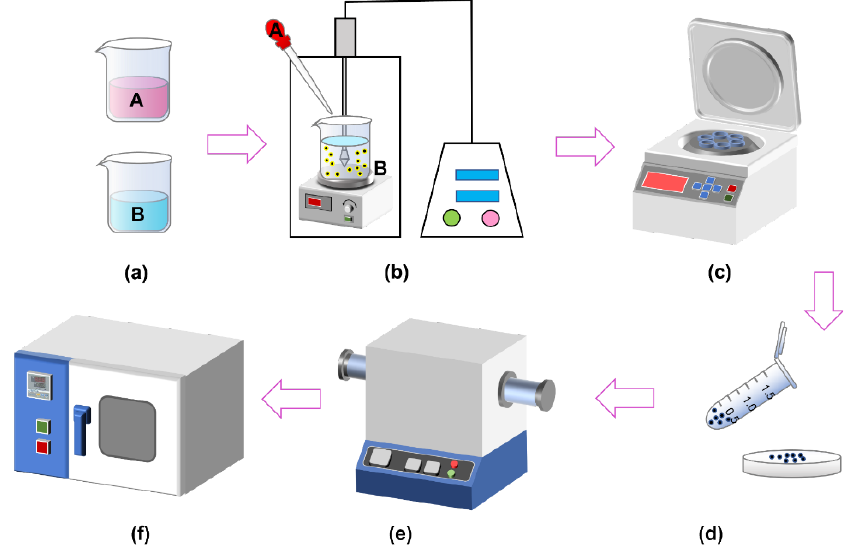
Solution A was obtained by adding anhydrous cobalt chloride and stannous chloride dihydrate to 50 mL of ethylene glycol solution. Triethylene glycol (TEG) and ethanol were mixed in a volume ratio of 1:5 to obtain 300 mL of Solution B. Dimethyldiallylammonium chloride was added to adjust the pH of the solution to 6.0 and 0.1 g of polyvinylpyrrolidone (PVP) was added. Solution B was placed in the ultrasonic disperser, accompanied by magnetic stirring at a stirring rate of 200 rpm/min, ultrasonic power of 480 W, frequency of 20 KHz. We added Solution A to Solution B drop by drop using a rubber-tipped dropper (Figure 2a,b).